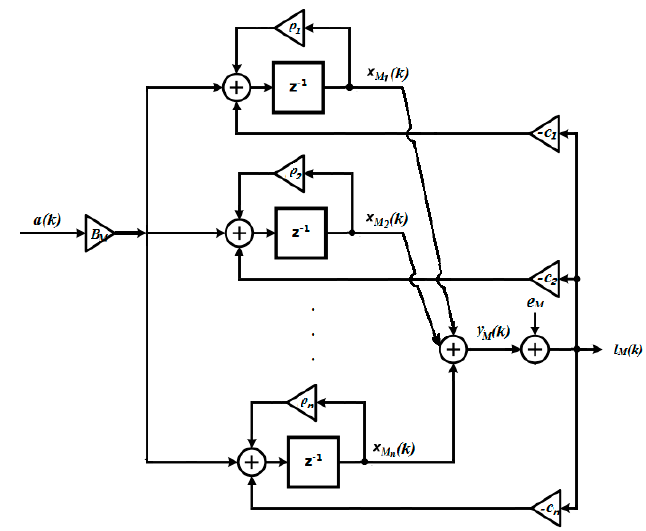
Figure 6. Linearized n th order Δ∑ modulator with parallel state.